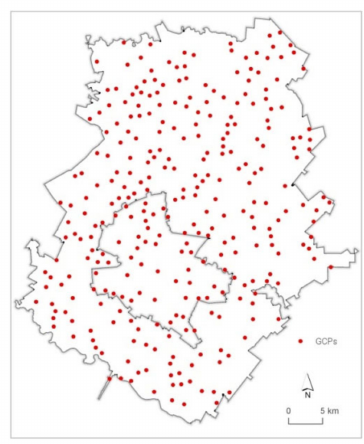
Figure 7. Map of random point sampling for Bucharest–Ilfov area used in accuracy evaluation of CLC and Landsat classification of built-up areas (1990 and 2018).